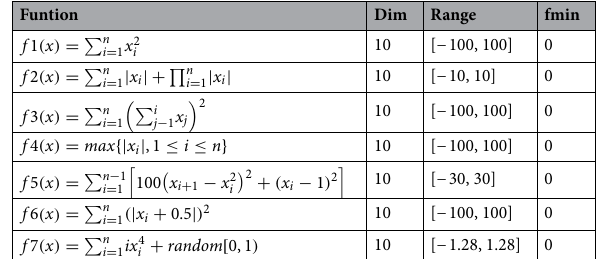
Table 2. Uni-modal test functions.